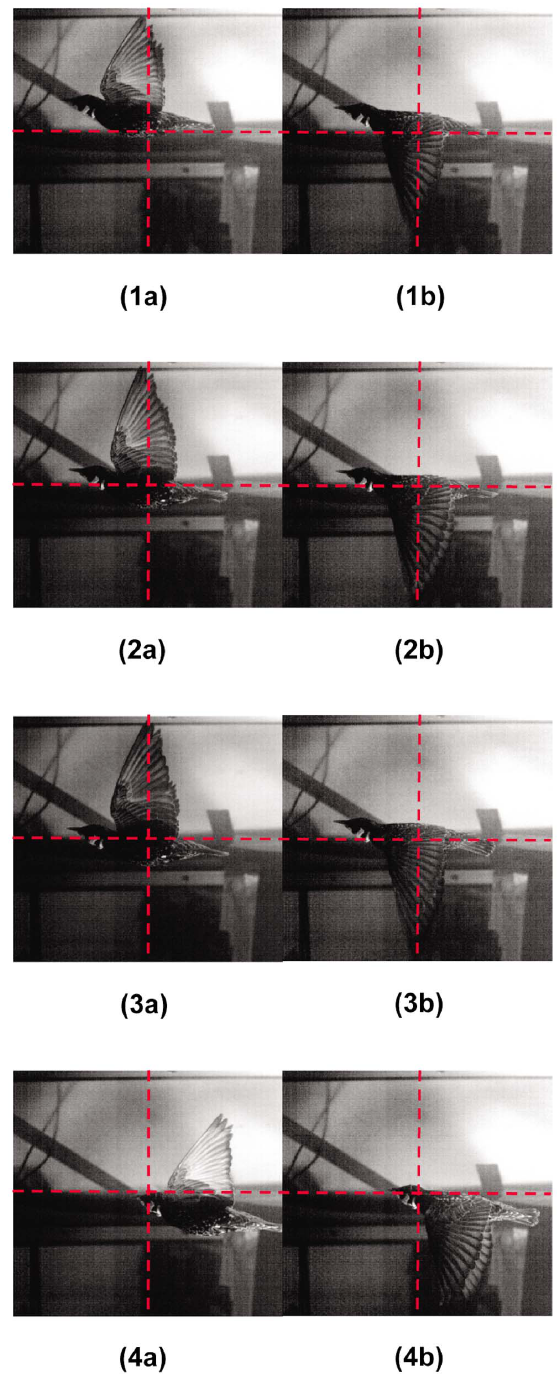
Figure 4. Different positions of the starling during the four wingbeats. The labels of the photographs correspond to the wingbeat number; ‘a’ marks the beginning of the downstroke, and ‘b’ marks the beginning of the upstroke. Each image center embedded with a red dashed cross lines for a visualization of the starling’s position during each wingbeat.